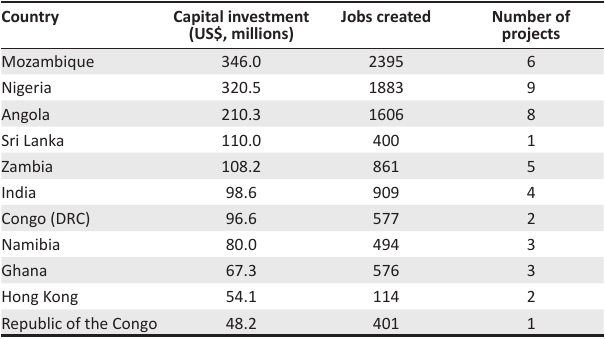
TABLE 6: Major destinations for agricultural foreign direct investment outflows from South Africa, 2003–2014.